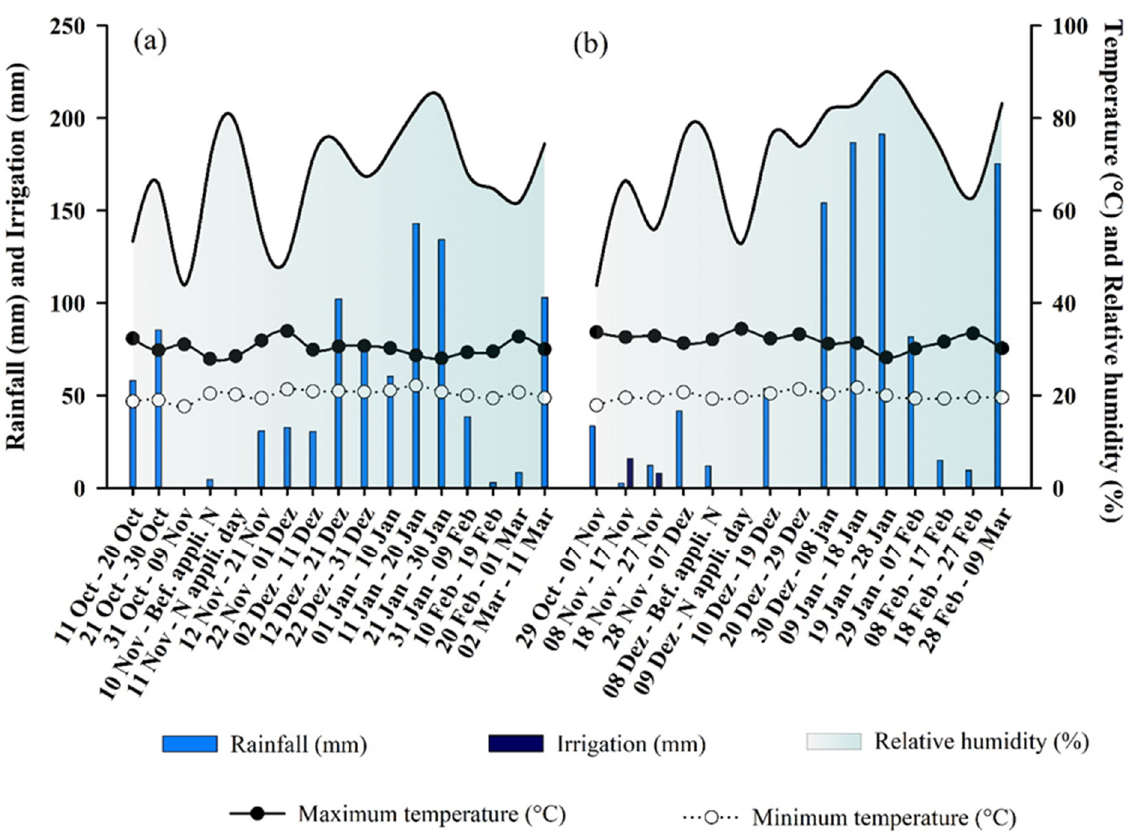
Figure 1. Pluviometric precipitation (mm), air relative humidity (%), maximum and minimum temperature (°C), and irrigation (mm) for corn grown on clayey soil ( a ) and corn grown on sandy soil ( b ). Bef. appli. N: Before application nitrogen day in topdressing. N appli. Day: Day of nitrogen application in topdressing. Table 1. Chemical and granulometric analysis of an Oxisol (clayey texture), Ultisol (sand texture) and interpretation of values for the surface layer (0.00–0.20 m).